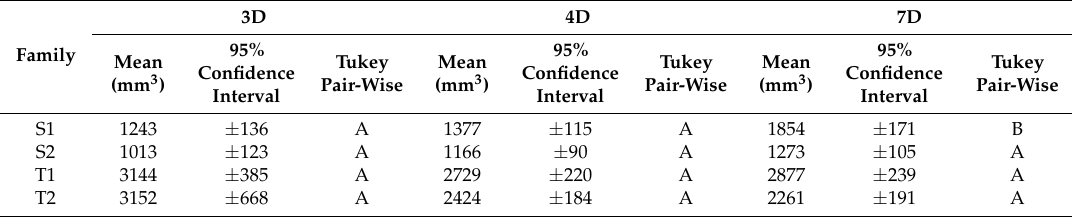
Table 4. Summary of seedling volume increment (mm 3 ) by rainfall and family.